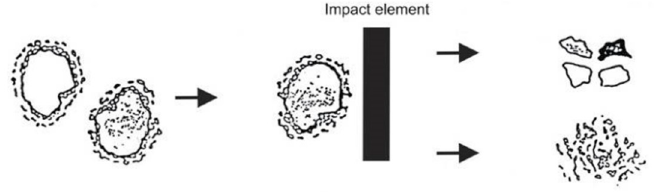
Figure A5. Schematic diagram of matrix release from coatings of used binding material–result of elementary crushing operation [3].